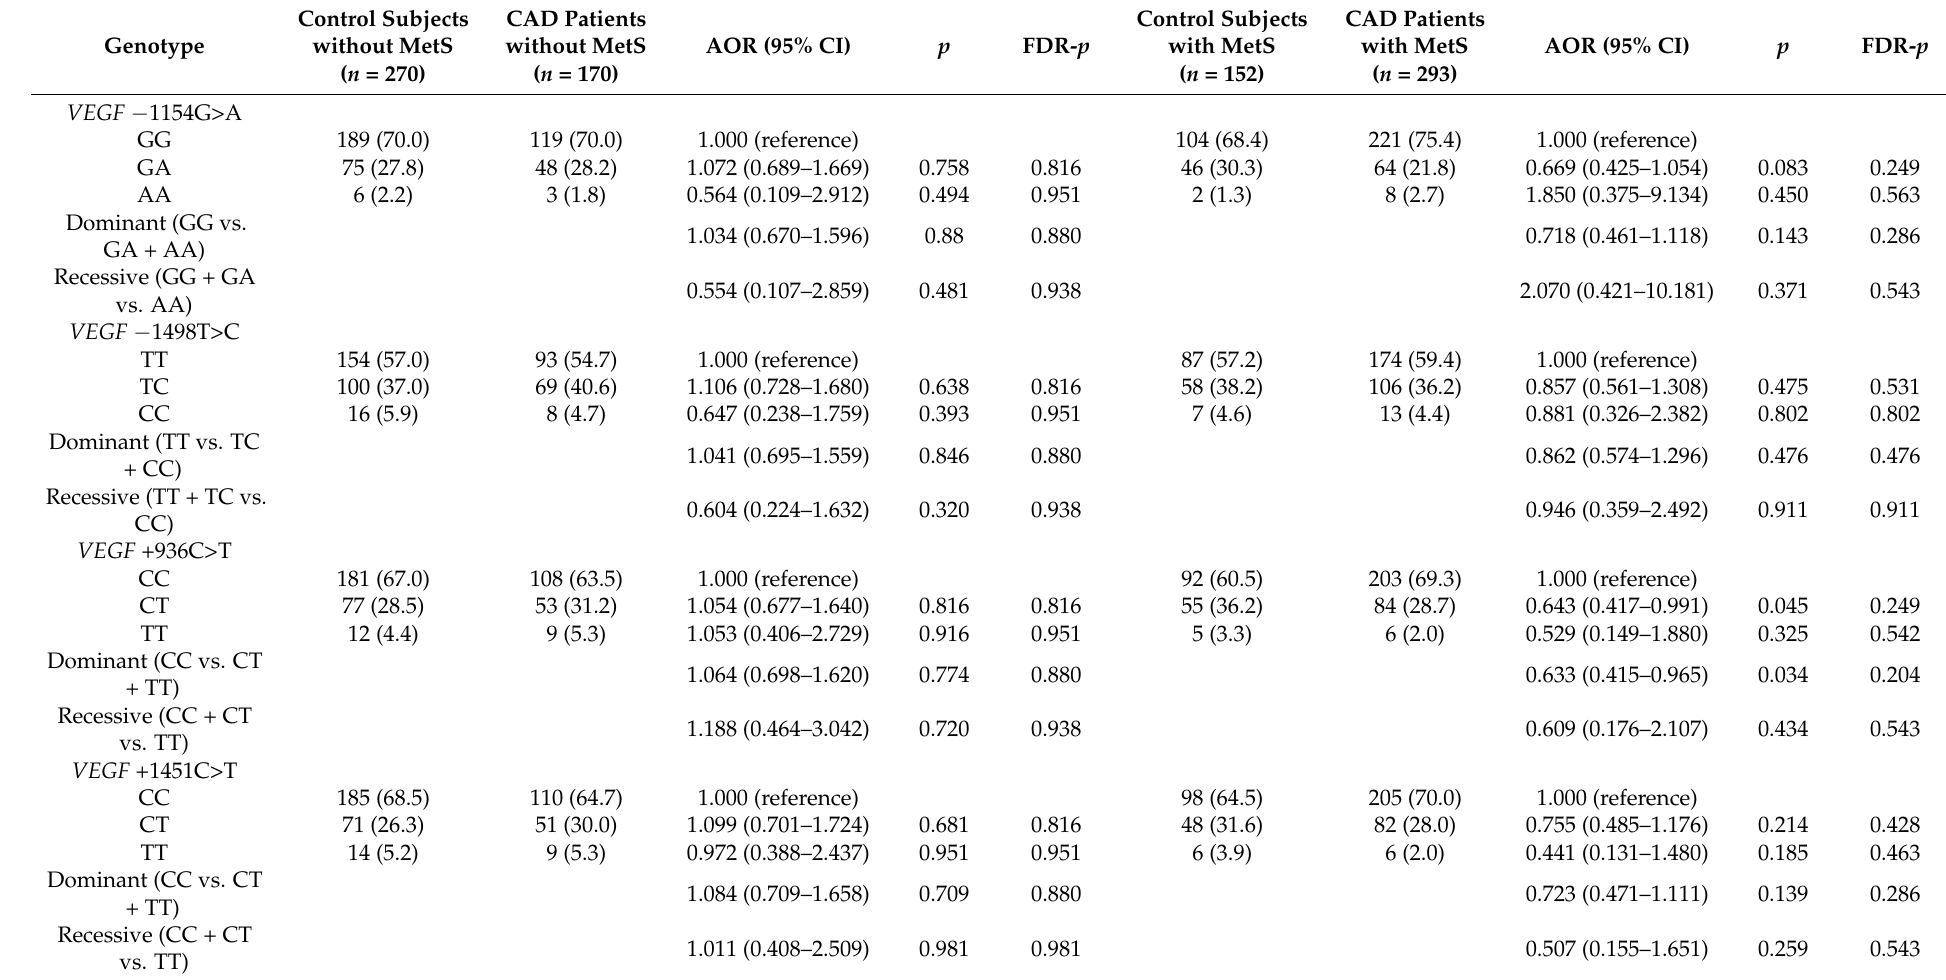
Table 3. Comparison of genotype frequencies of VEGF polymorphisms between CAD patients and control subjects according to